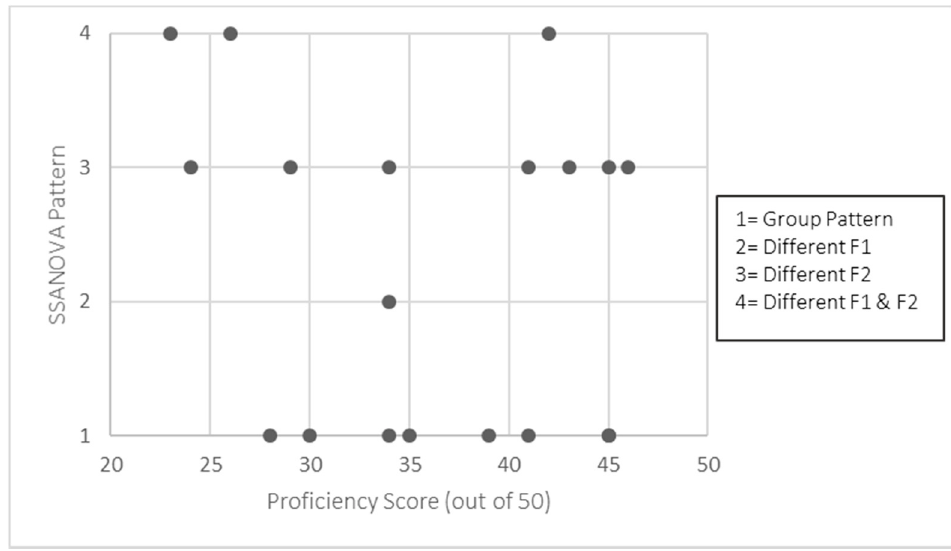
Figure 8. Smoothing Spline pattern type by Spanish proficiency score.